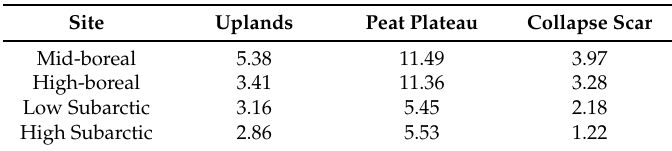
Table 4. Q 10 values for surface respiration in upland (UL), peat plateau (PP) and collapse scars (CS) across different ecoregions (sites).